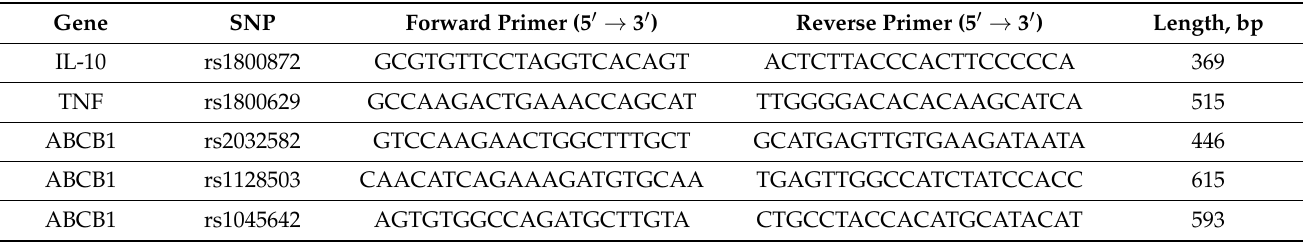
Table 3. Characteristics of the primers for each